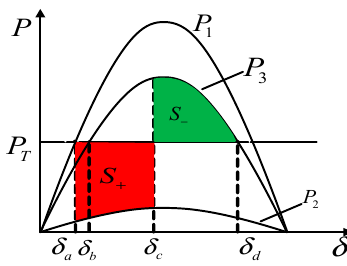
Figure 2. Generator angle characteristic.